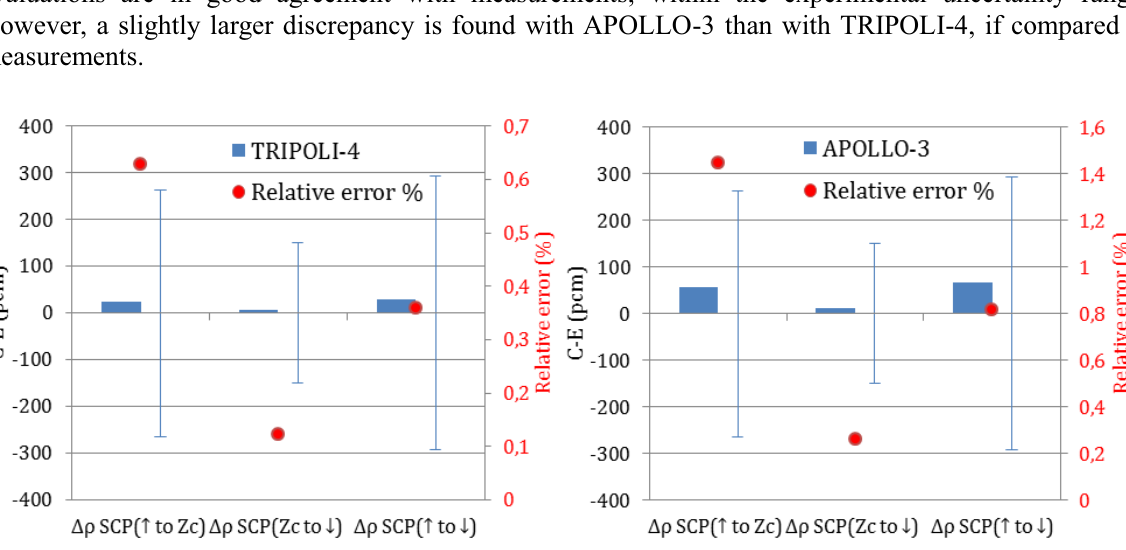
Figure 2. Control rod worth C - E in pcm for TRIPOLI - 4 (left) and APOLLO - 3